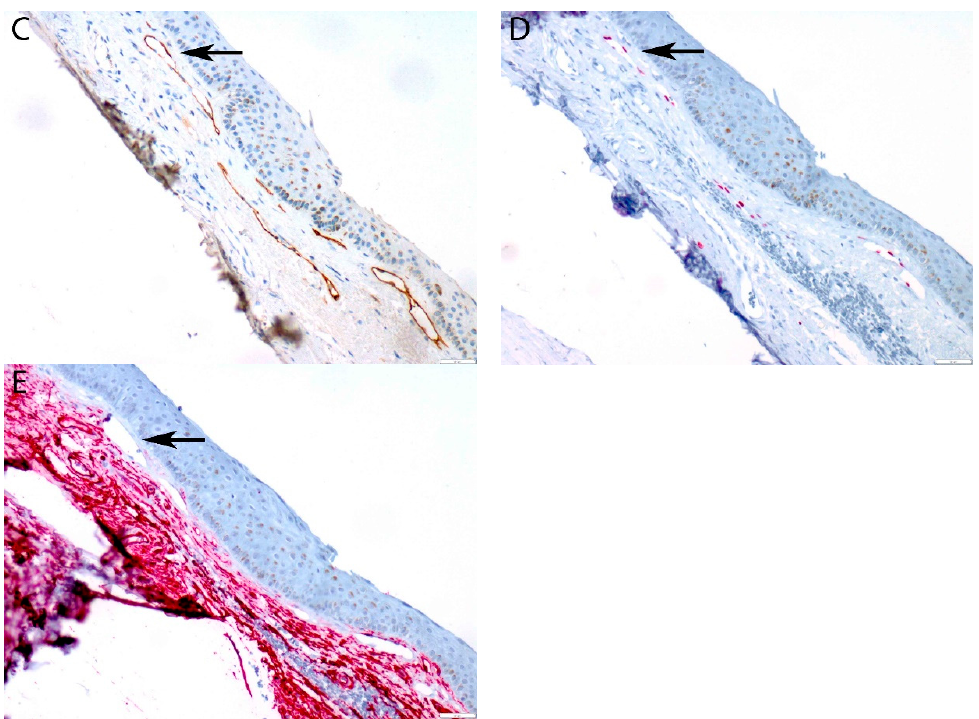
Figure A3. Conjunctival control tissue staining pattern. ( A ) CD31 stains all endothelial cells (arrow). ( B ) D2-40 stains conjunctival lymphatic vessel endothelium (arrow). ( C ) LYVE-1 stains conjunctival lymphatic vessel endothelium (arrow). ( D ) Prox-1 is positive in the nuclei of lymphatic endothelial cells (arrow). ( E ) CD34 is positive in blood vessel endothelium and negative in lymphatic endothelium (arrow). Conjunctival stroma also stains positive. (All panels: original magnification 100×).